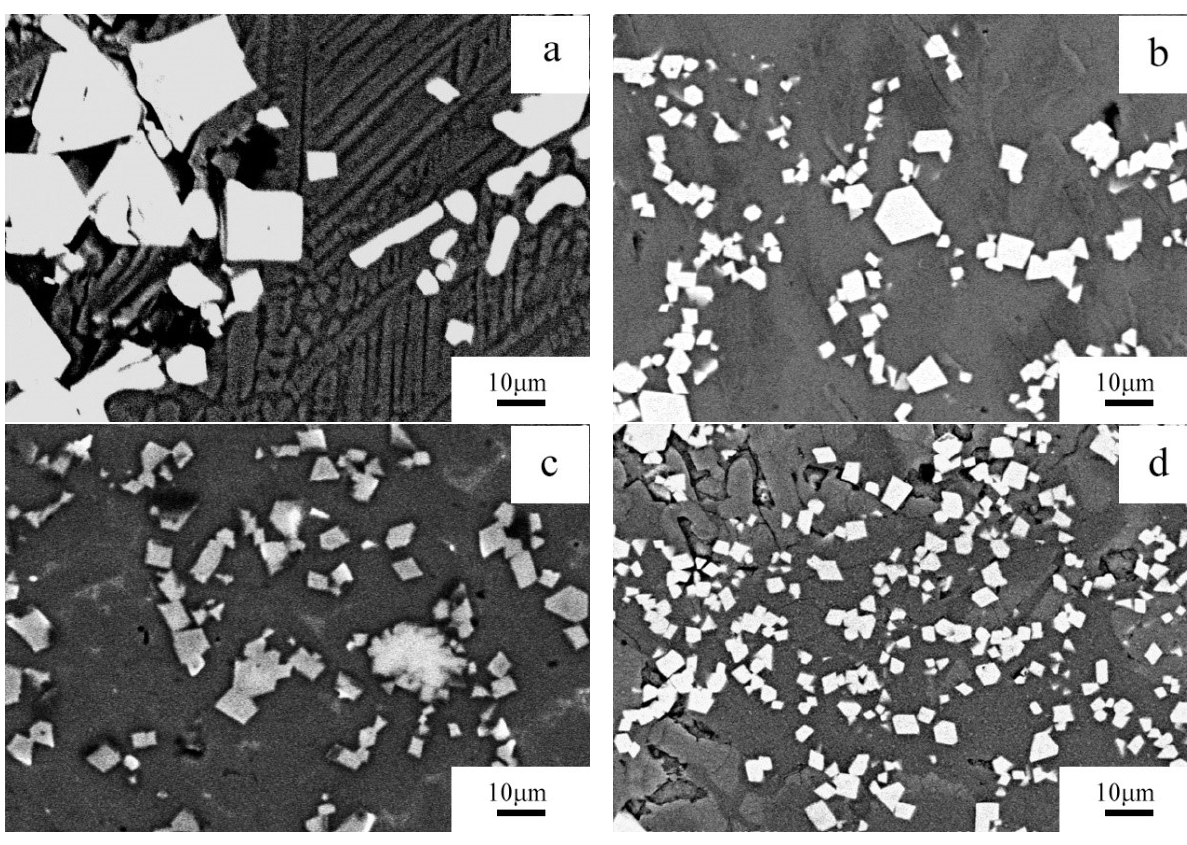
Figure 4: Microstructure of the samples at different basicities